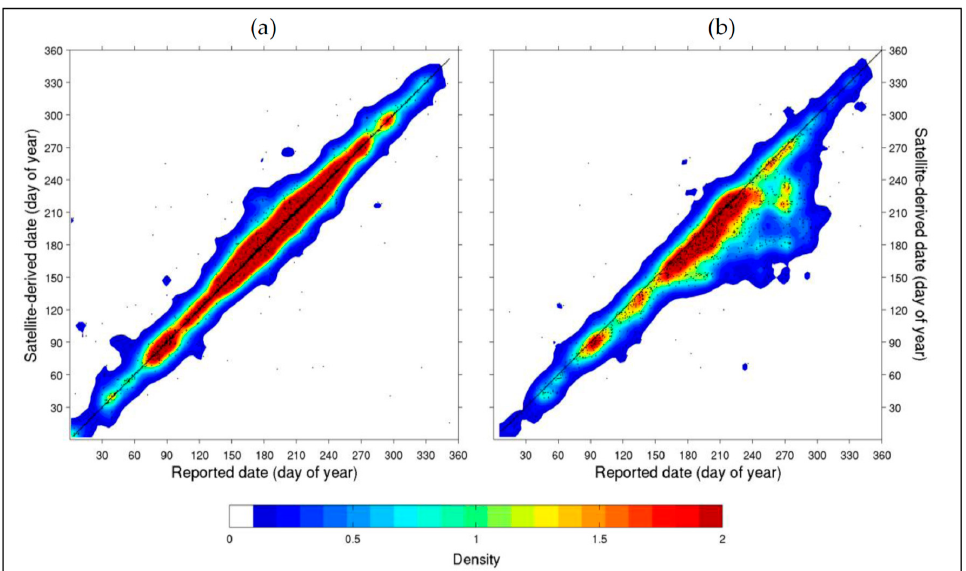
Figure 5. Pairwise comparison between reported and satellite-derived fire ( a ) start dates ( N = 2395, MEF = 0.91) and; ( b ) end dates ( N = 1397, MEF = 0.73). The colorbar indicates the number of pairs within each satellite-derived/reported date bin. White color indicates null or very low density.